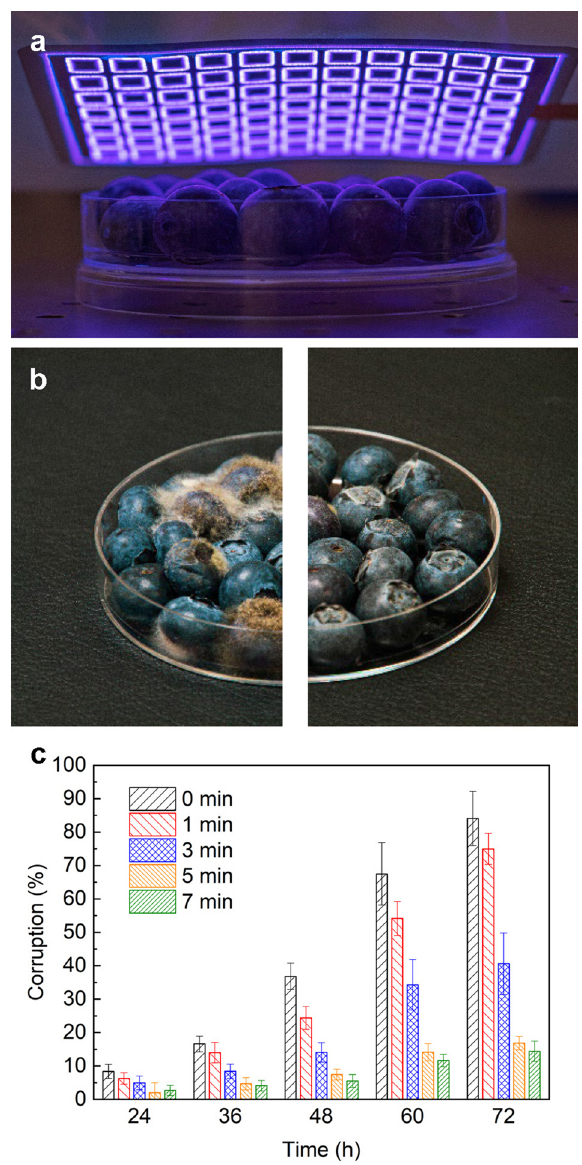
driven by 15 W with 30 kHz bipolar square wave